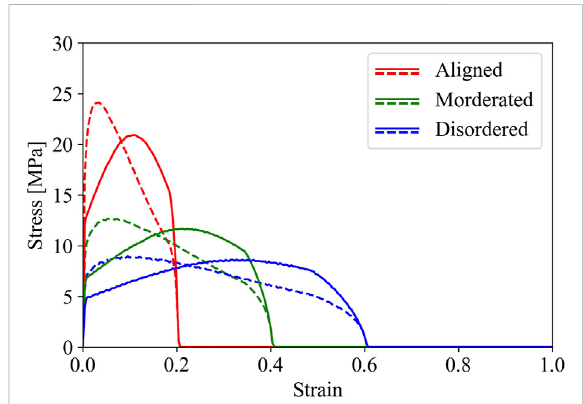
FIGURE 7 The effect of the heterogeneity of arrangements of fi ber minerals within the microstructure. The plot shows the comparison between a Gaussian distribution of the arrangement of the fi brous minerals within the microstructure of cementitious matrix and the Gamma distribution. This latter refers to a left-skewed distribution, entailing that the fraction of mineral fi bers that bears the load are characterized by shorter length l and greaterend-to-endlateralseparation w. Matricescharacterizedby fi brous minerals whose l and w follow a left-skewed gamma exhibit greater stress at failure as well as an earlier failure compared to matrices whose arrangement of fi bers follow a normal (Gaussian)